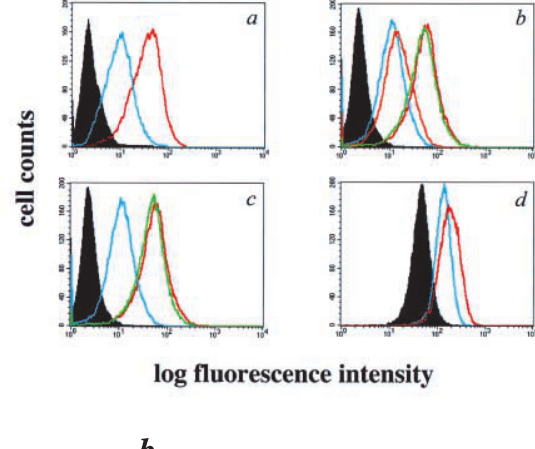
Simvastatin does not affect human endothelial cell viability and protein synthesis. ECs were treated with 500 U/ml IFN- γ (1) for 24 hrs in the presence or absence of 10 µ M simvastatin (2). a , Cell viability was determined using trypan blue. b , Protein synthesis was measured by BCA (Pierce). Results were obtained in inde- pendent experiments with ECs from three different donors.